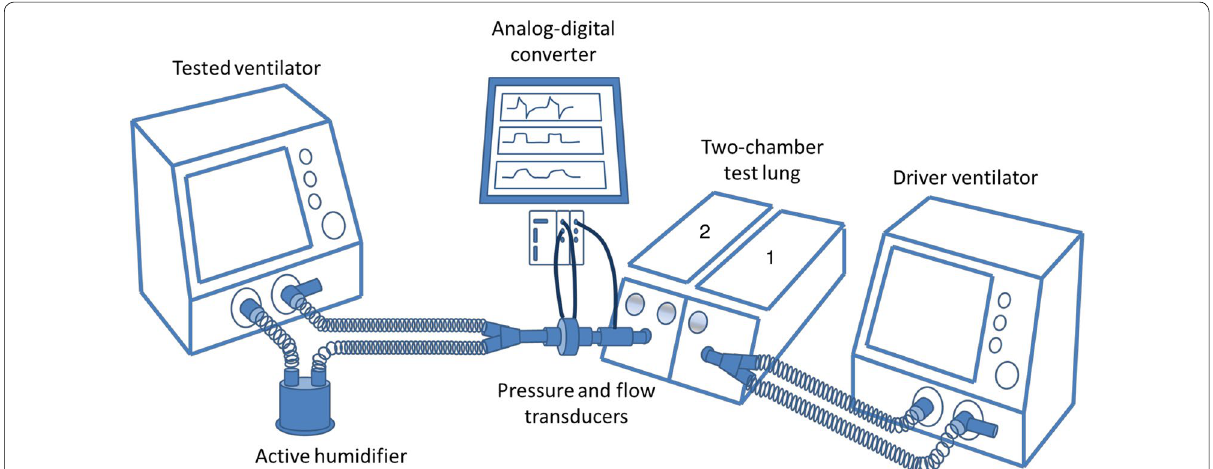
Fig. 1 Experimental setup. A chamber of a two‑chamber test lung was connected to a driving ventilator set in volume‑controlled ventilation mode. The second chamber (2) was connected to the tested ventilator by a double limb circuit with an active humidifier. The two chambers of the test lung were linked by a rigid metal piece, so that the positive pressure insufflated by the driving ventilator into the first chamber (1) generates a negative pressure in the second chamber, recognized as an inspiratory effort by the tested ventilator. Data were acquired via an